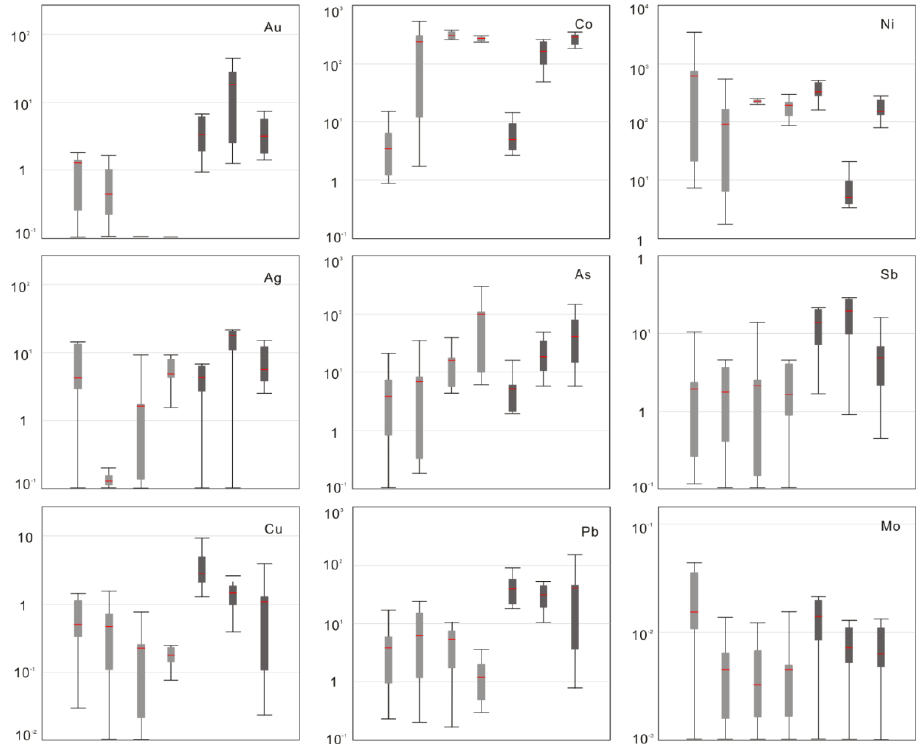
Figure 8. Box-and-whisker diagrams showing in situ Au, Co, Ni, Ag, As, Sb, Cu, Pb, and Mo from pyrite of the Lijiapuzi deposit. The red bar indicates the median value, the box encompasses the 25th to 75th percentiles of the data, and the whiskers indicate the minimum and maximum values. Light-grey bars show the Py1 spot data, while the dark-grey ones show the Py2 data.